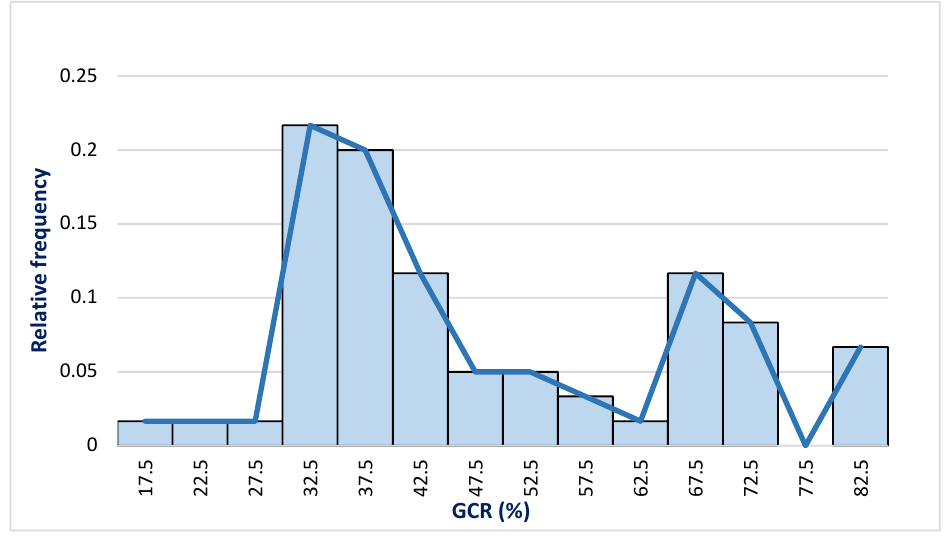
. Figure 16. Histogram of the index GC . 𝐺𝐺𝐺𝐺